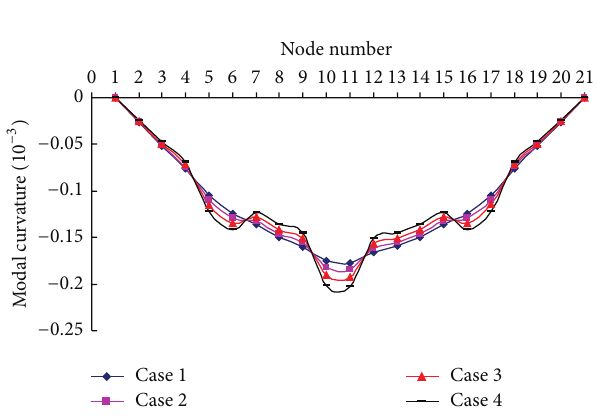
Figure 6: Modal curvature for multiple damage locations.